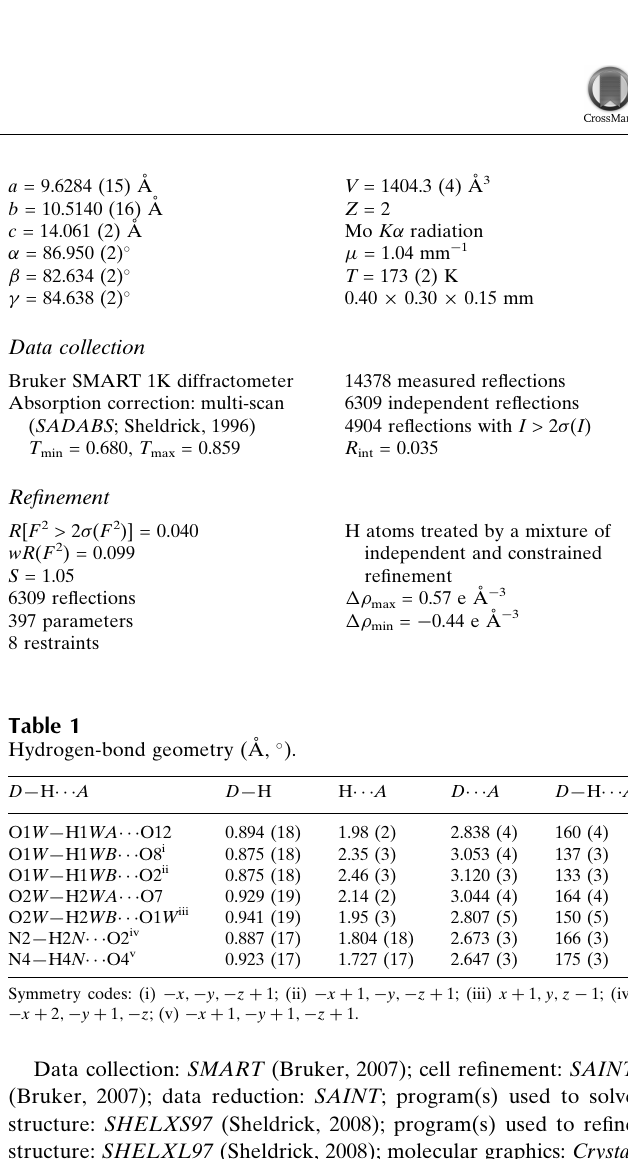
For copper carboxylate coordination polymers containing 3- bpmp, see: Johnston et al. (2008). For the synthesis of 3-bpmp, see: Pocic et al. (2005).